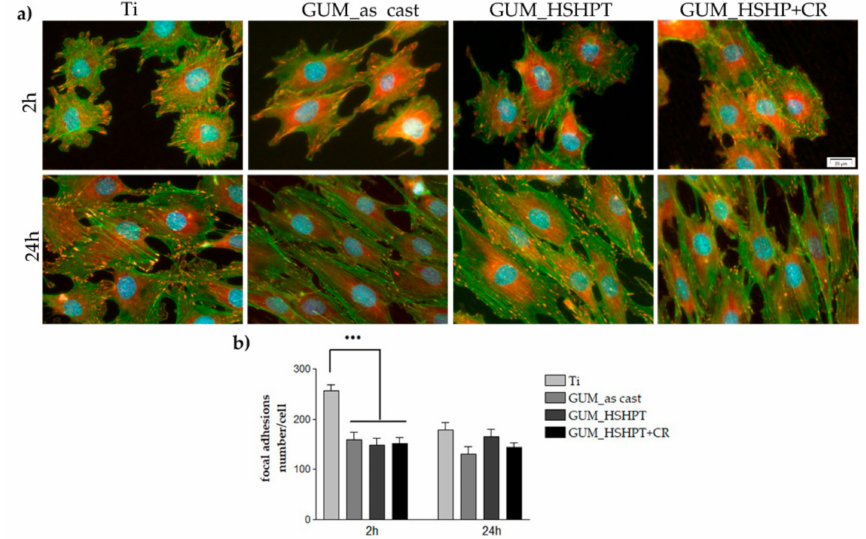
Figure 5. Fluorescent images of MC3T3-E1 preosteoblasts grown on tested substrates for 2 and 24 h, respectively. ( a ) Green fluorescence: actin cytoskeleton; red fluorescence: vinculin signals. Scale bar: 20 mm; ( b ) quantification of focal adhesions. Results are presented as means ± SD ( n = 15